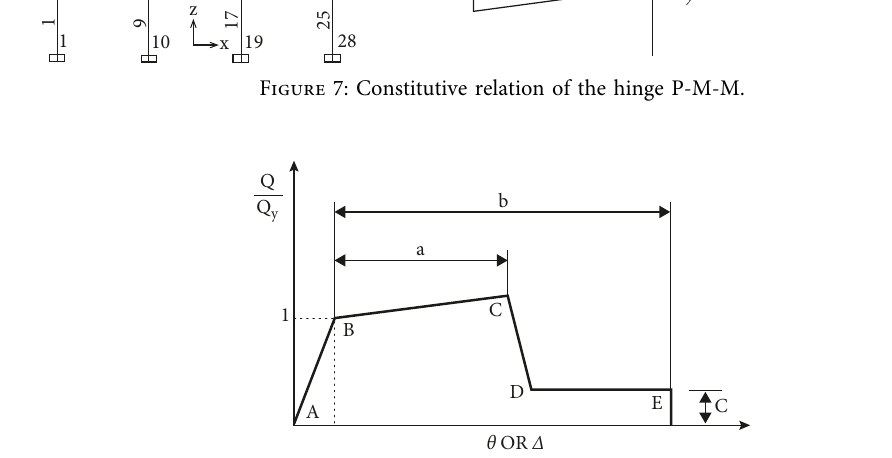
Figure 8: General force-deformation curve for members and components.